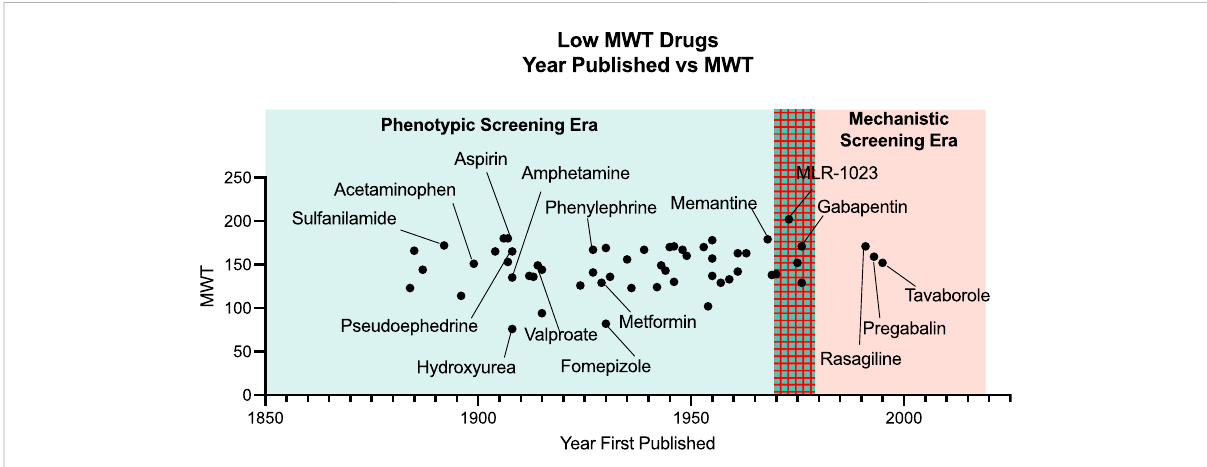
FIGURE 2 Fiftysix drugs referenced by Derek LoweLowe, D. (2014). The smallest drugs. (Online). Available: https://www.science.org/content/blog-post/ smallest-drugs (Accessed March 21, 2022). And the year that they were published are plotted as Year First Published vs . MWT of the drug. Prior the 1970s all drugs were screened by some form of phenotypic screen as opposed to in vitro target based screening methods that arose in the